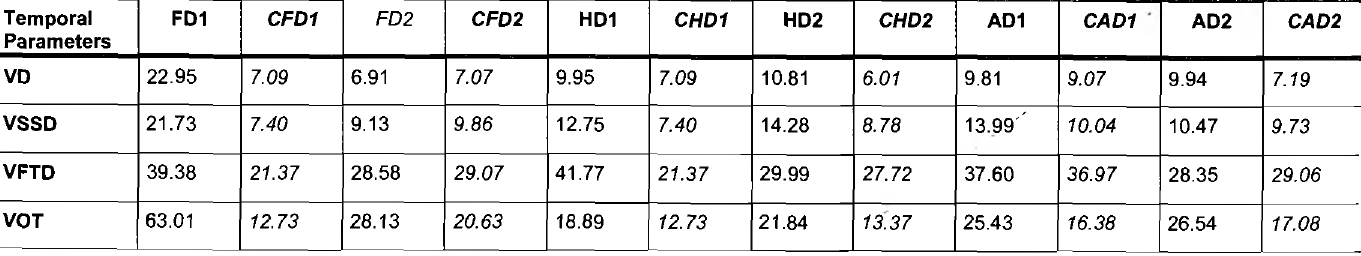
Table 3: Coefficients of variation of the temporal parameters of vowel duration, vowel steady state duration, vowel formant transition duration and voice onset time Temporal